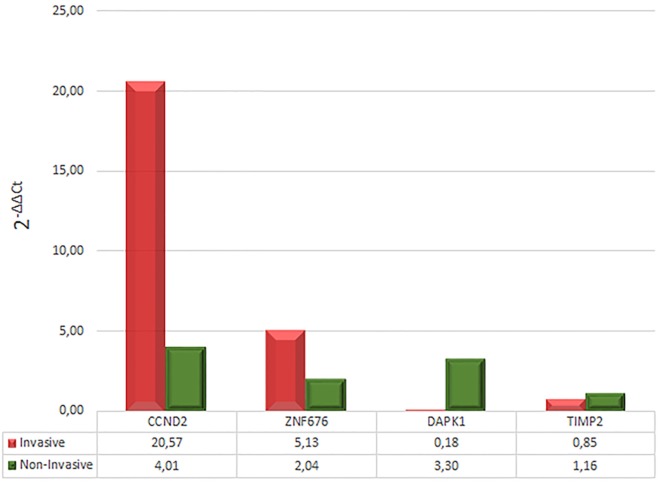
Relative expression levels (fold change) of CCND2, ZNF676, DAPK1, and TIMP2.